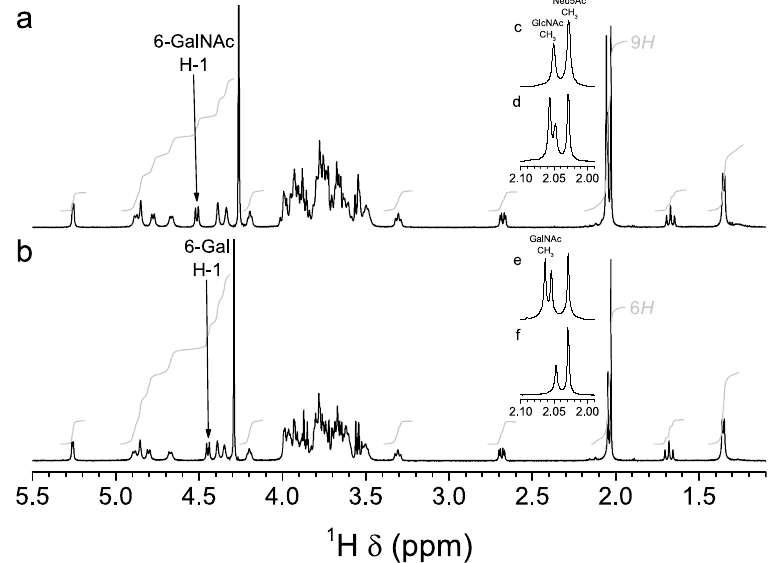
Figure 3. 1D 1 H NMR spectra of CPS preparations from serotypes 2 and 1/2 in 33 mM phosphate pD 8.0 in D 2 O. ( a , b ) Full spectrum. ( c–f ) Expansion of the methyl region. ( a , d ) SS2to1/2 mutant, 500 MHz, 77 °C. ( b , f ) SS1/2to2 mutant, 500 MHz, 75 °C. ( c ) Serotype 2 field strain, 600 MHz, 50 °C 17 . ( e ) Serotype 1/2 field strain, 700 MHz, 42 °C 19 . Specific characteristics of the 1 H NMR spectrum due to the presence of GalNAc in the native serotype 1/2 CPS were also found in the spectrum of the CPS from the corresponding mutant expressing serotype 1/2 CPS. Conversely, the spectrum of the CPS from the mutant expressing serotype 2 CPS, as well as that of the native serotype 2 CPS, lacked the signal attributed to N -acetyl of GalNAc.